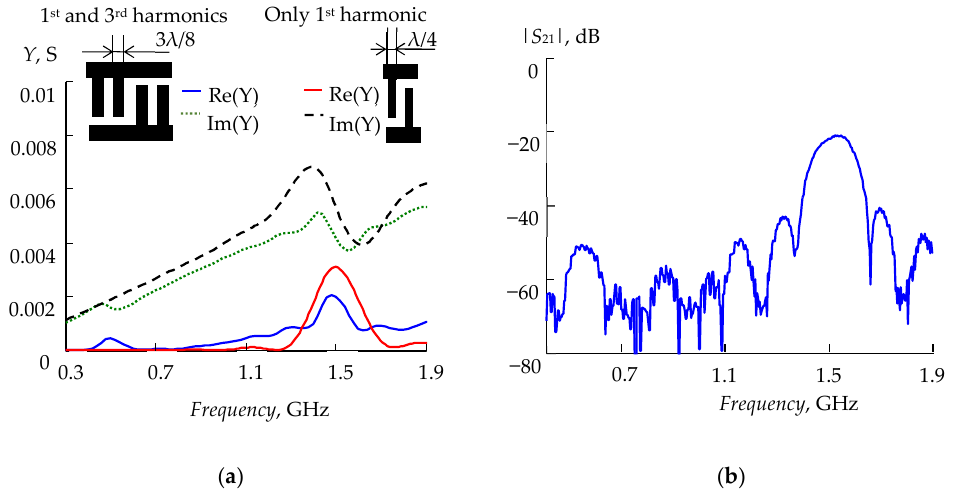
Figure 8. SAW DL: ( a ) principle of operation of the transducers at harmonics (main and 3rd harmonic excitation for IDT with split electrodes and only main for IDT with λ/4); ( b ) frequency response calculated by FEM for scheme without “parasitic” LC elements.